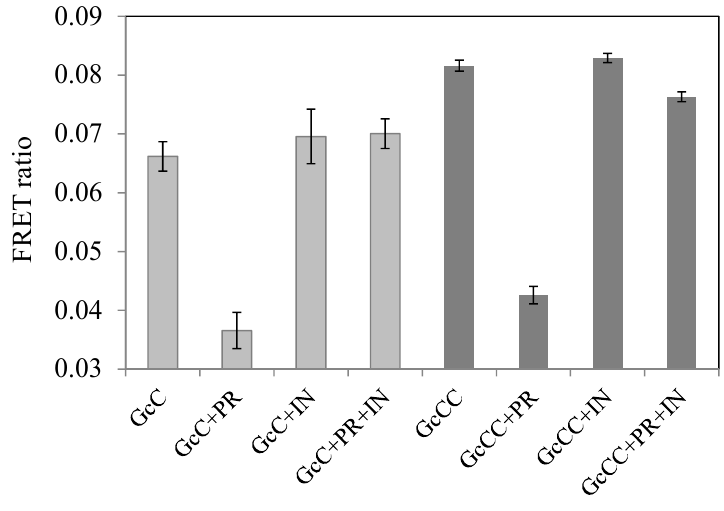
Figure 3. Detection of HIV-1 protease’s inhibition using the FRET probes. The reaction was conducted at 37 °C for 30 min and stopped by the addition of a stop buffer to the reaction buffer. All measurements were performed at room temperature. Symbols: GcC, a FRET probe with single acceptor protein; GcCC, a FRET probe with a tandem acceptor protein; PR, protease; IN: inhibitor. All experiments were performed in triplicate and the error bars stand for standard